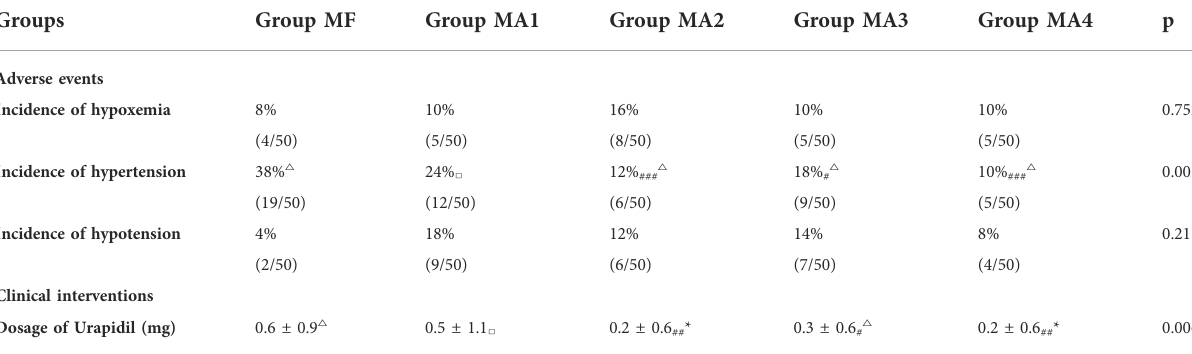
TABLE 4 Comparison of the fi ve groups with regard to adverse events and clinical interventions (n =